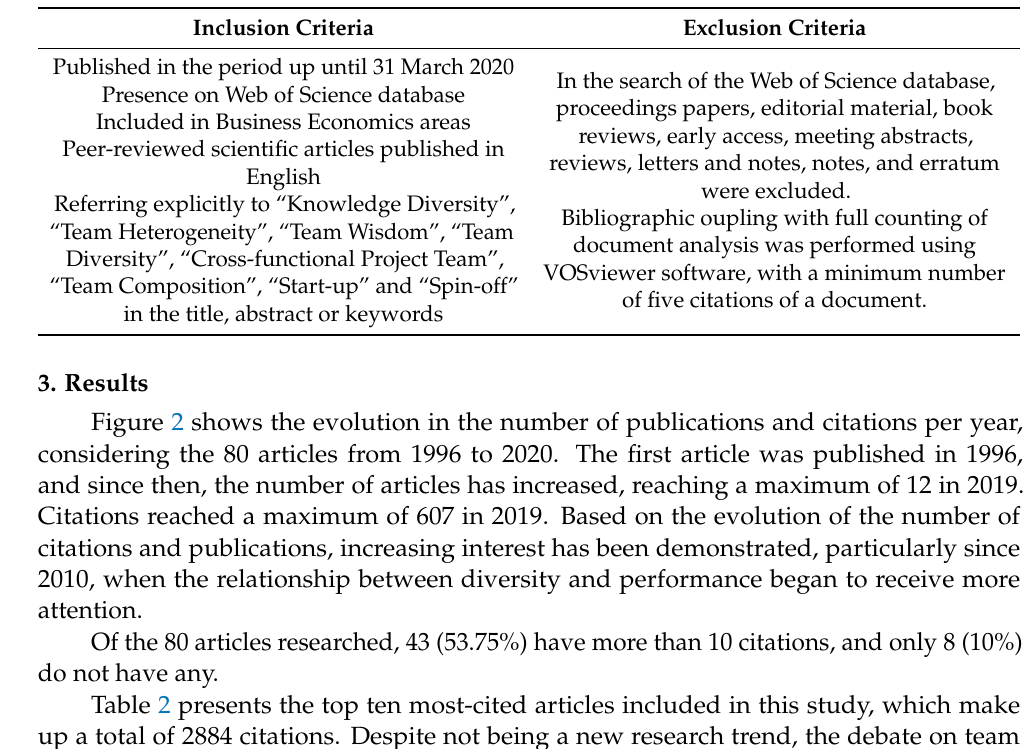
Table 1. Criteria for inclusion and exclusion of publications in the SLR.